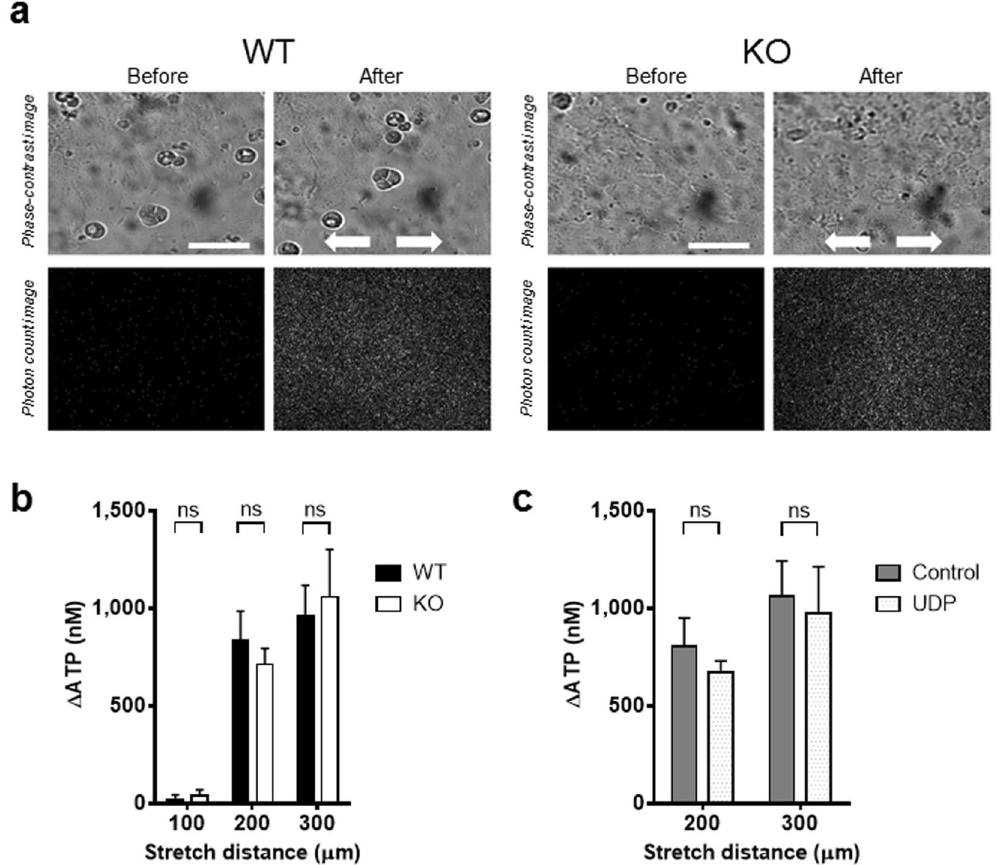
Figure 6. Visualization of stretch-evoked ATP release from primary-cultured urothelial cells. ( a ) The upper panels show urothelial cells in phase-contrast images, and the lower panels show photon count images (white dots) in the same field. The left and right panels show the images before and after mechanical stretch, respectively. The stretch speed was 100 µ m/s, and the distance was 200 µ m. Cells were extended transversely (indicated by arrows). Scale bar: 100 µ m. ( b ) Comparison of stretch-induced ATP release from mouse primary- cultured urothelial cells at different stretch distances (100 µ m, 200 µ m, and 300 µ m) between WT and P2Y 6 -KO cells, and no differences were found between the 2 groups (P = 0.59 at 100 µ m, P = 0.91 at 200 µ m, P = 0.95 at 300 µ m by a Mann-Whitney test). Numbers of data collected for 100 µ m, 200 µ m, and 300 µ m were: 10, 20, and 10 in WT cells, and 9, 19, and 10 in P2Y 6 -KO cells, respectively. ( c ) Comparison of stretch-induced ATP release from WT mouse primary-cultured urothelial cells at different stretch distances (200 µ m, and 300 µ m) between the absence and presence of UDP (100 µ M), and no differences were found between the 2 groups (P = 0.39 at 200 µ m, P = 0.77 at 300 µ m by an unpaired t-test). Numbers of data collected for 200 µ m and 300 µ m were: 11 and 16 in control group, and 12 and 15 in UDP group, respectively. ns, not